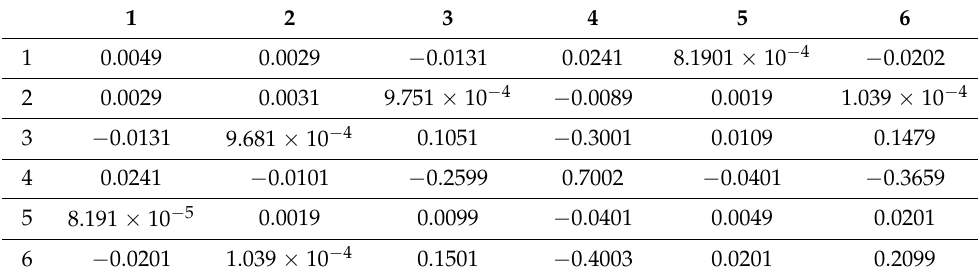
Table 5. Weight matrix data.